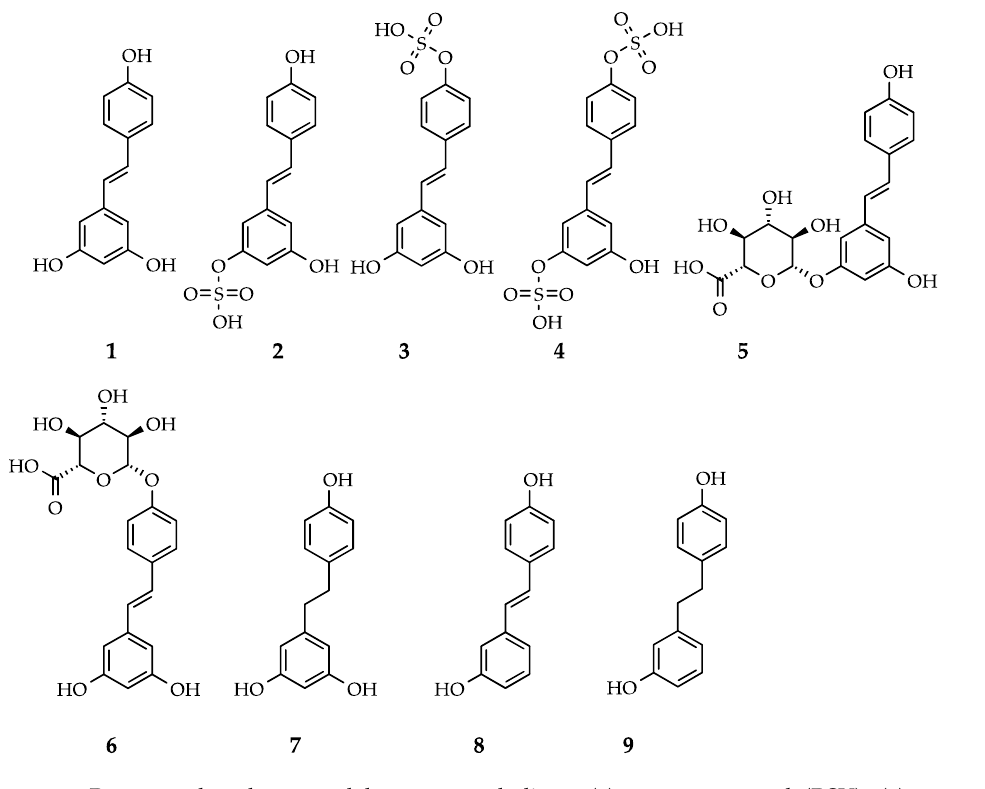
Figure 1. Resveratrol and reported human metabolites: ( 1 ) trans -resveratrol (RSV); ( 2 ) trans - resveratrol-3- O -sulfate; ( 3 ) trans -resveratrol-4’- O -sulfate; ( 4 ) trans -resveratrol-3,4’- O -disulfate; ( 5 ) trans -resveratrol-3- O -glucuronide; ( 6 ) trans -resveratrol-4’- O -glucuronide; ( 7 ) dihydroresveratrol (DHR); ( 8 ) 3,4’- O -dihydroxy- trans -stilbene; and ( 9 ) lunularin (also see Table 1).